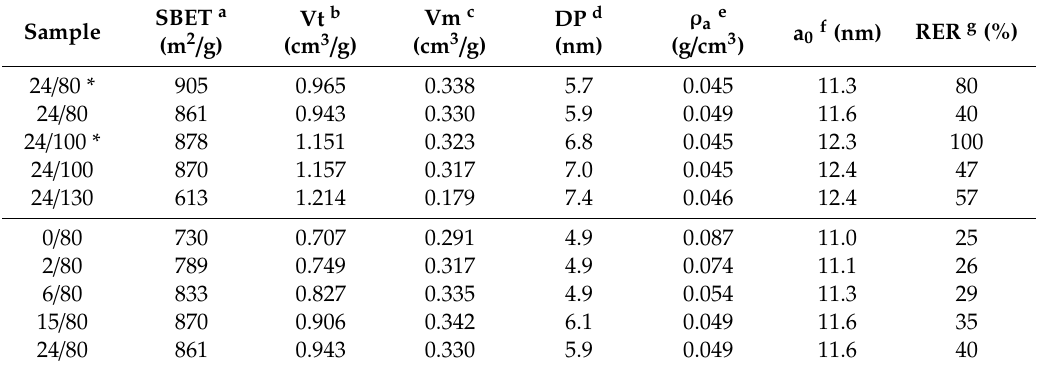
Table 1. Structural properties of the samples obtained at di ff erent hydrothermal treatment times and temperatures.